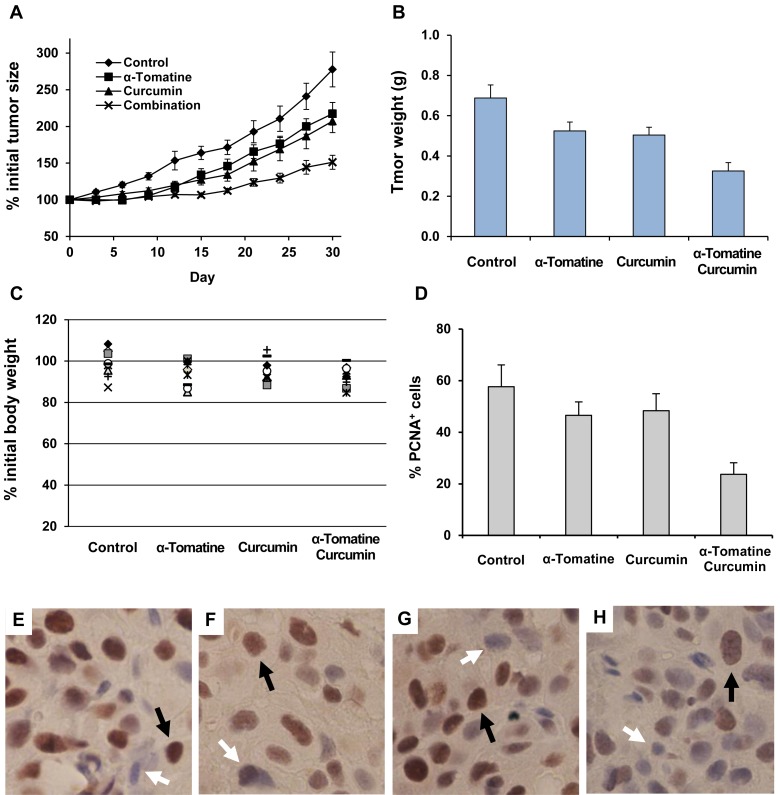
Effects of α-tomatine and curcumin alone or in combination on the growth of PC-3 xenograft tumors and body weight of SCID mice.Male SCID mice were injected subcutaneously with PC-3 cells (2 × 106 cells/0.1 ml) suspended in 50% Matrigel in RPMI medium. After about 4 weeks, mice with PC-3 xenograft tumors (0.6–1.0 cm wide and 0.6–1.0 cm long) were i.p injected with vehicle, α-tomatine (5 mg/kg body weight), curcumin (5 mg/kg body weight), and a combination of α-tomatine (5 mg/kg body weight) and curcumin (5 mg/kg body weight) once every three day for 30 days. Immunohistochemical staining of PCNA was done to determine the effect of the various treatments on tumor cell proliferation. (A) Tumor size was expressed as percent of initial tumor size. (B) The weight (g) of each tumor was measured at the end of the experiment in mice after sacrifice. (C) Body weight was expressed as percent of initial body weight. (D) Percentage of PCNA positive cells in tumors from animals treated with vehicle, α-tomatine, curcumin or the combination of α-tomatine and curcumin. Representative micrographs of PCNA immunohistochemical staining in tumors from the control group (E), the α-tomatine-treated group (F), the curcumin-treated group (G) and the combination-treated group (H) are shown. Black arrows indicate positive PCNA staining and white arrows indicate negative PCNA staining.